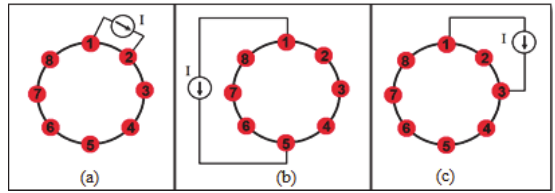
Fig. 6: (a) Neighboring (b) Opposite (c) Cross methods of current injection.